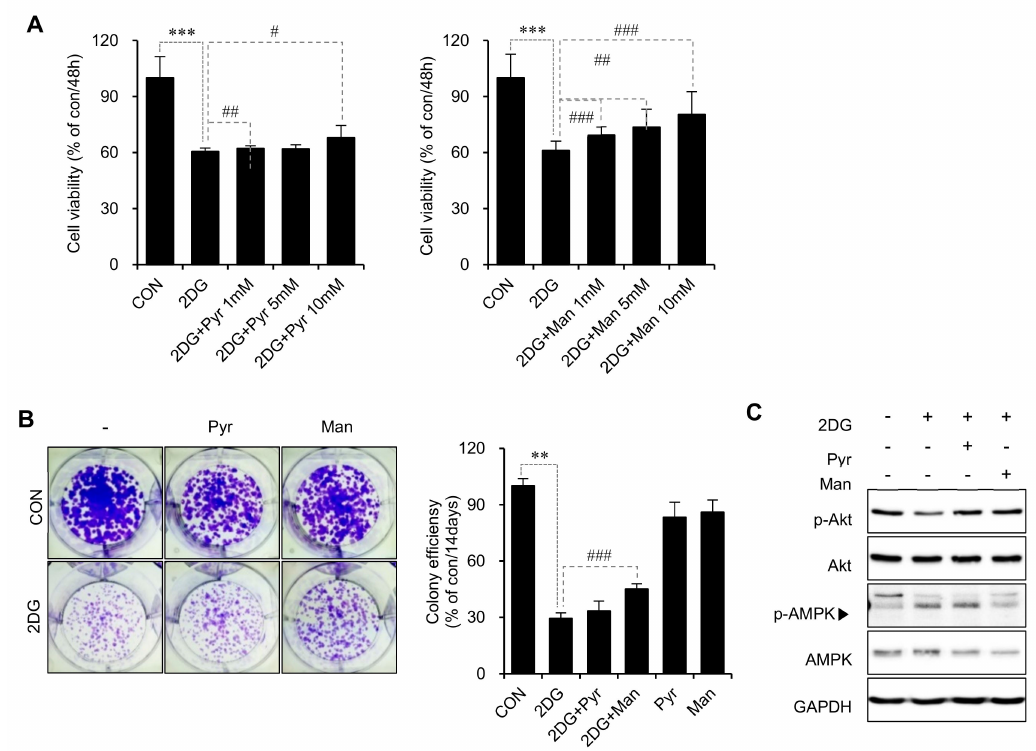
Figure 3. Inhibition of N-linked glycosylation contributes to the anticancer e ff ect of 2DG in SCC15 cells. ( A ) SCC15 cells were treated with 2.5 mM 2DG in the presence or absence of pyruvate (left panel) or mannose (right panel) for 48 h, and cell viability was measured by the MTT assay. The values are expressed as a percentage of the control. Error bars represent mean ± SD ( n = 4). *** p < 0.001 versus CON. # p < 0.05; ## p < 0.01; ### p < 0.001 versus 2DG. ( B ) Colony formation assay. Cells were treated with 2DG in the presence or absence of pyruvate or mannose as indicated and stained with crystal violet after 14 d of incubation. Error bars represent mean ± SD ( n = 3). Statistical significance was determined using the Student’s t-test. ** p < 0.01 versus CON. ### p < 0.001 versus 2DG. ( C ) SCC15 cells were treated with 2DG in the presence or absence of pyruvate or mannose for 24 h, and protein expression was measured by western blot analysis. The phosphorylated and total levels of AKT and AMPK were measured; GAPDH was used as the loading